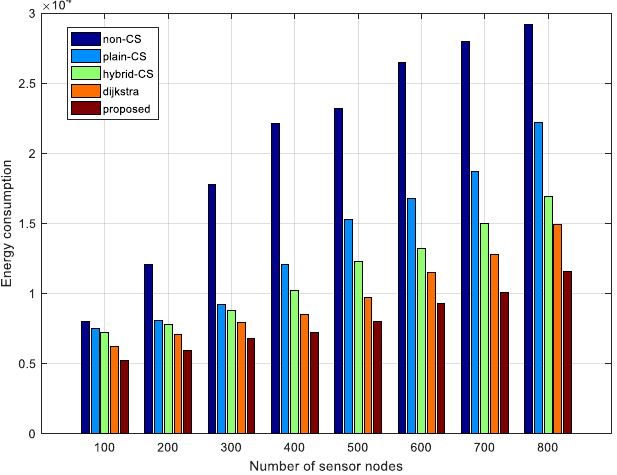
Figure 16. Energy consumption comparison of different data-gathering schemes vs. the number of sensor nodes.